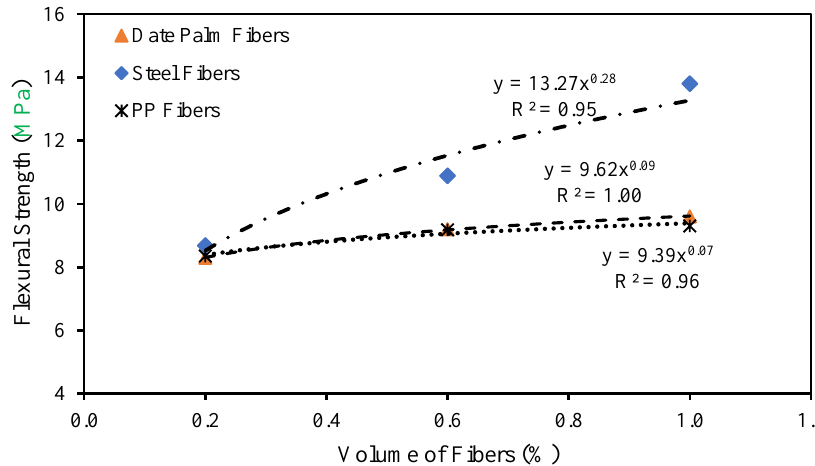
Figure 7. Relationship between the flexural strength and volume fractions of different fibers.